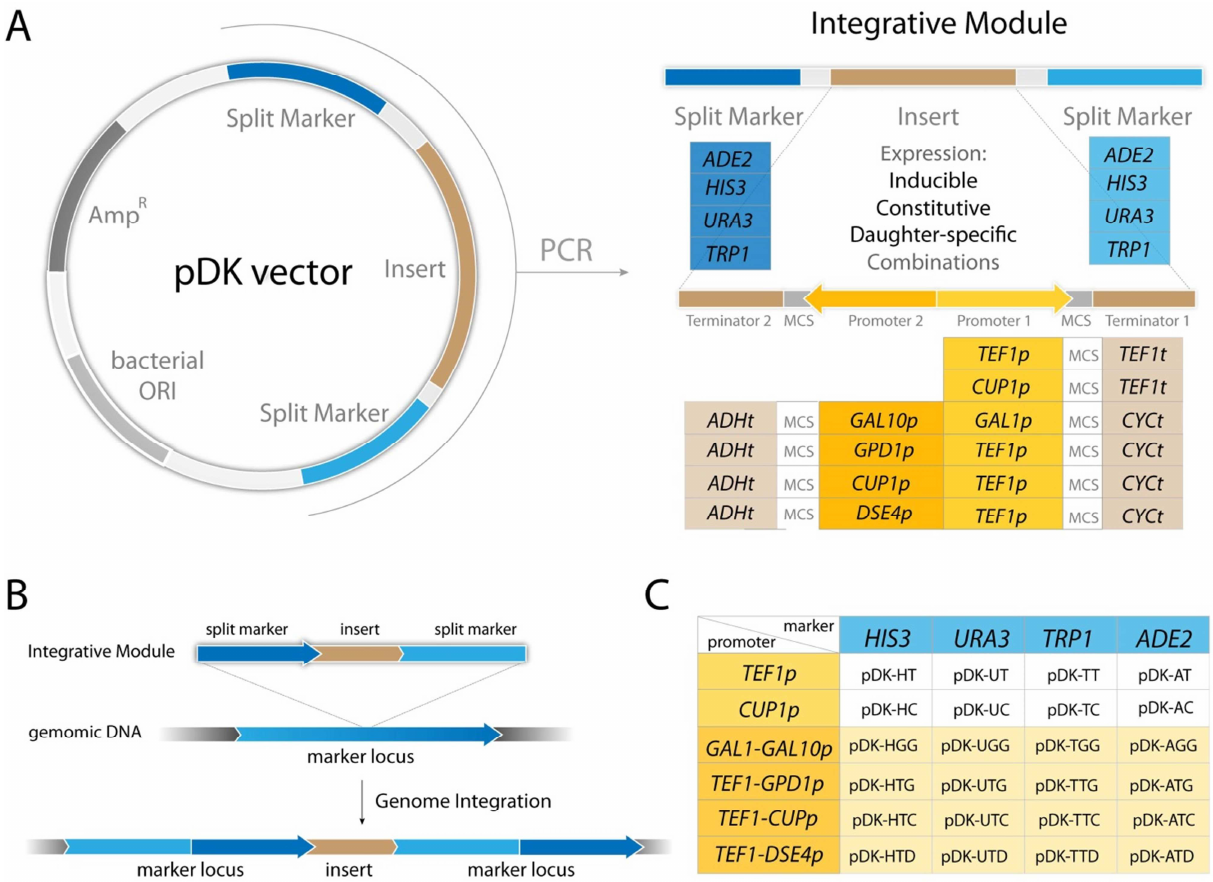
FIGURE 1: pDK vector series overview. (A) pDK vector with an integrative module flanked by a split marker. The customized insert is flanked by constitutive, inducible, or daughter-specific promoters. PCR is required for genetic integration. (B) Integration overview: the module is transformed into S. cerevisiae and inserted into the chromosome resulting in a marker locus duplication. (C) pDK vector set: constitutive, inducible, and four bi-directional promoter plasmids available for integration into four